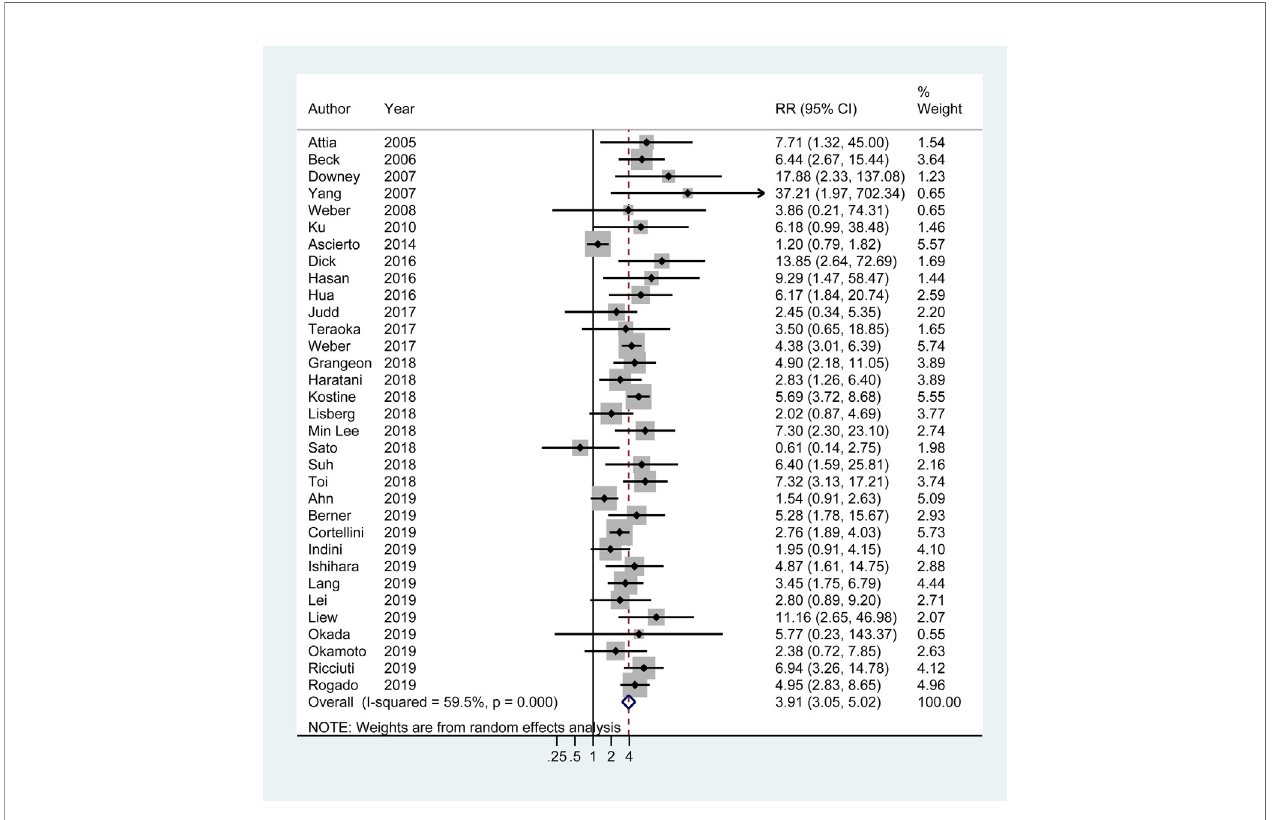
FIGURE 2 | Forest plot of the association of immune-related adverse events with tumor objective response rate (ORR) in cancer patients receiving immune checkpoint inhibitors. RR, risk ratio; CI, con fi dence